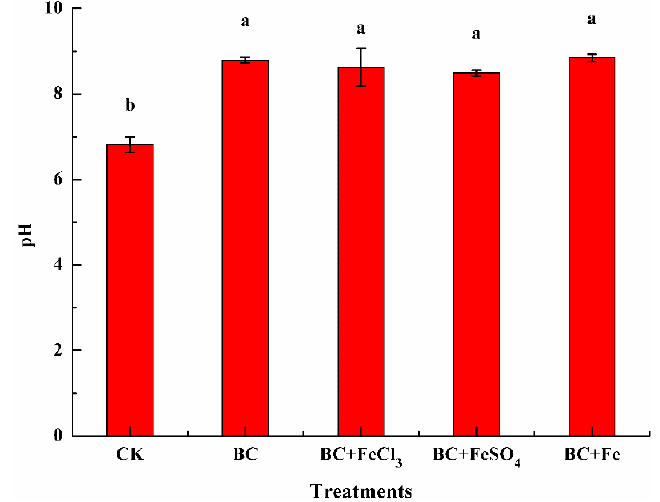
Figure 3. The effect of different treatments on soil pH. Note: different letters for the Figure 3 indicates that the differences are statistically significant ( P < 0.05).